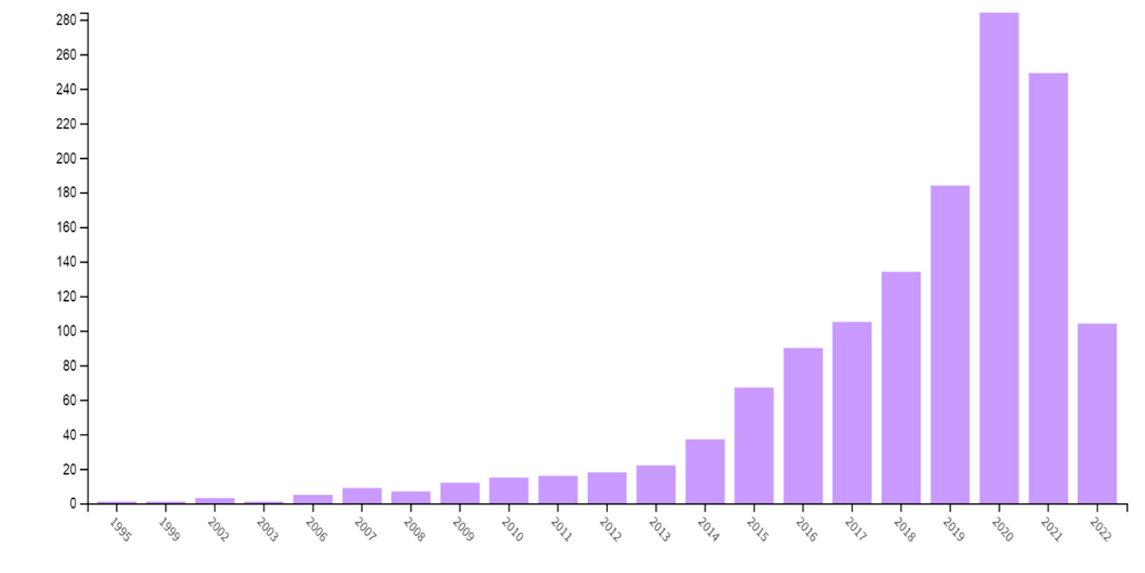
Figure 1. Number of publications by year. Table 1. Top 5 Journals with highest impact